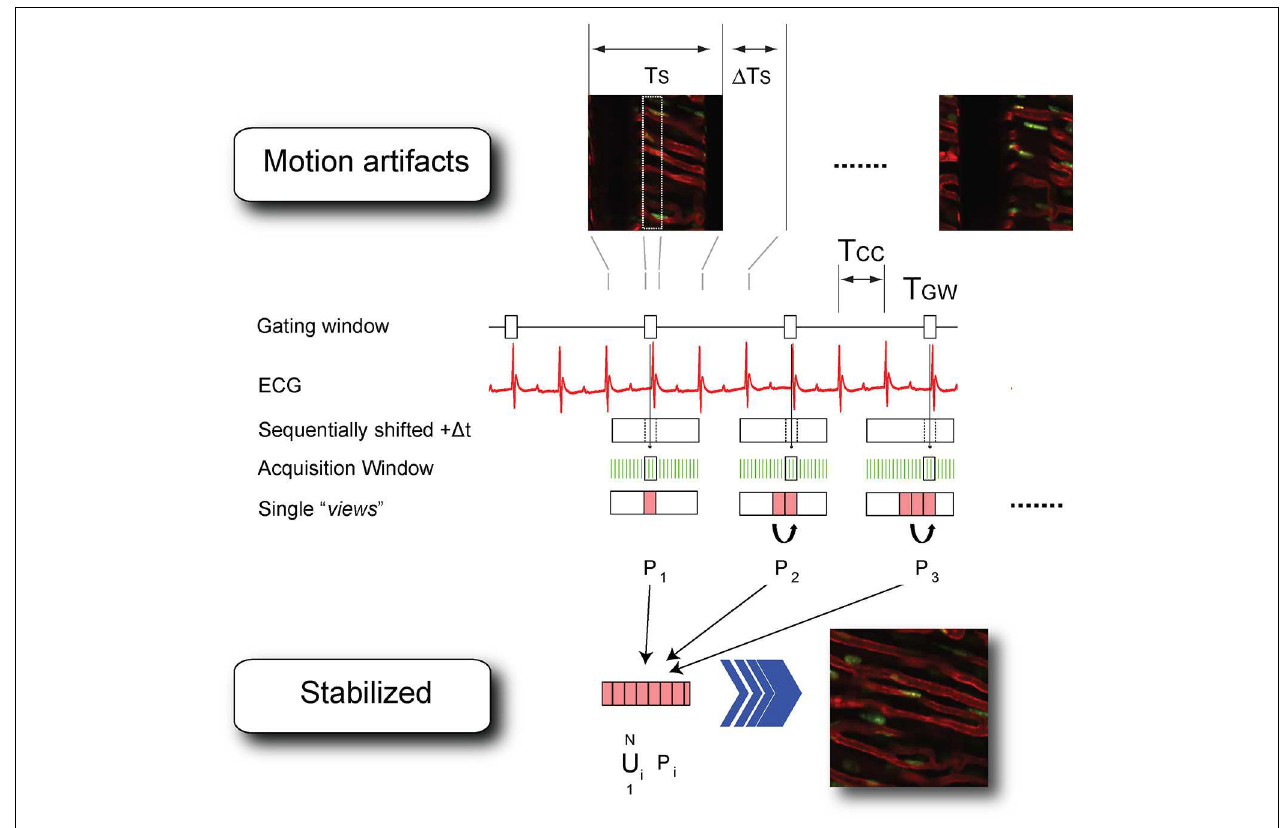
corresponding to the end-diastole. Segments P i (i = 1…N) are isolated from each image in correspondence to the time-gated window T GW and combined together in a final stabilized image which is truly representative of the heart’s morphology at the cardiac phase corresponding to the time-gated window. Adapted from Vinegoni et al.